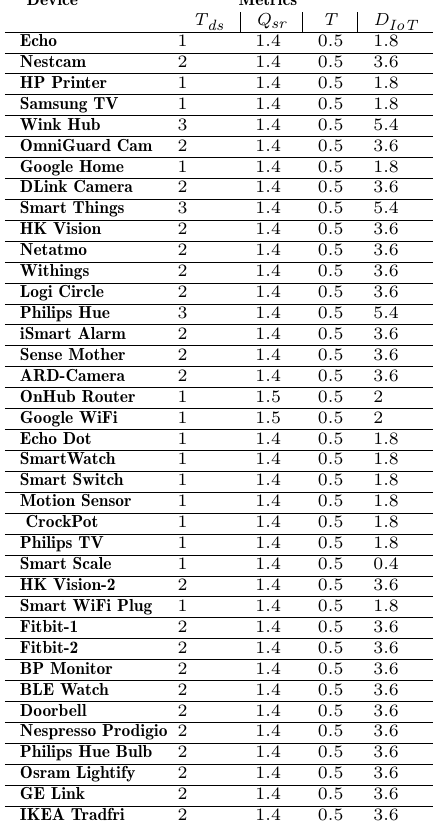
Table 2. Quality of Service and Degradation Results